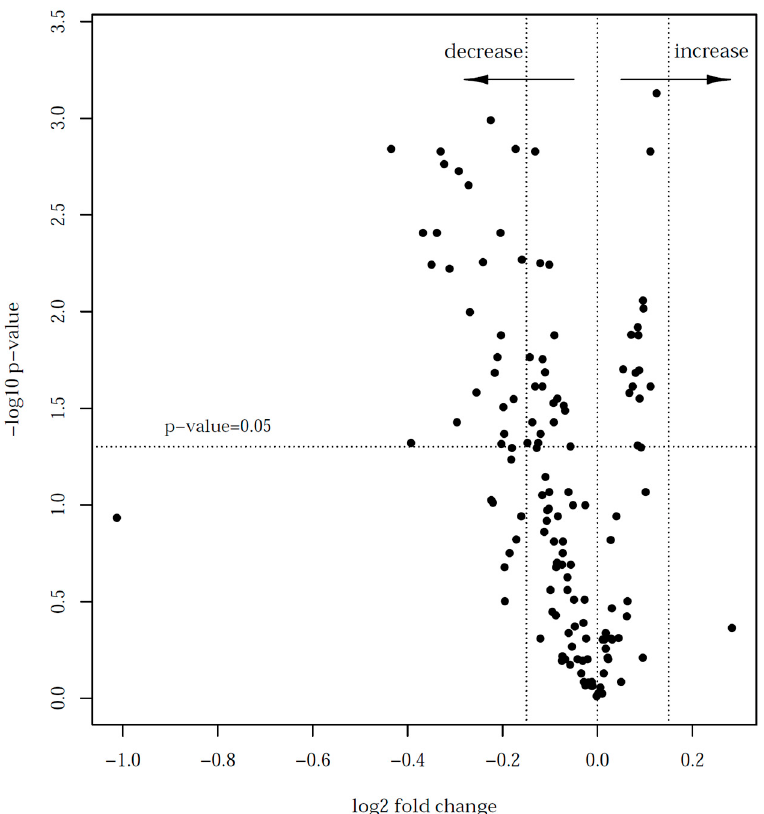
Figure 5. Volcano plot for the comparison of proteins in low- versus high-heat treated milk samples. The log two-fold change of protein expression between low- and high-heat treated milk samples is plotted against the corresponding p -values from a t -test given as negative decadic logarithm. A negative log two-fold change indicates a decrease in LFQ levels.